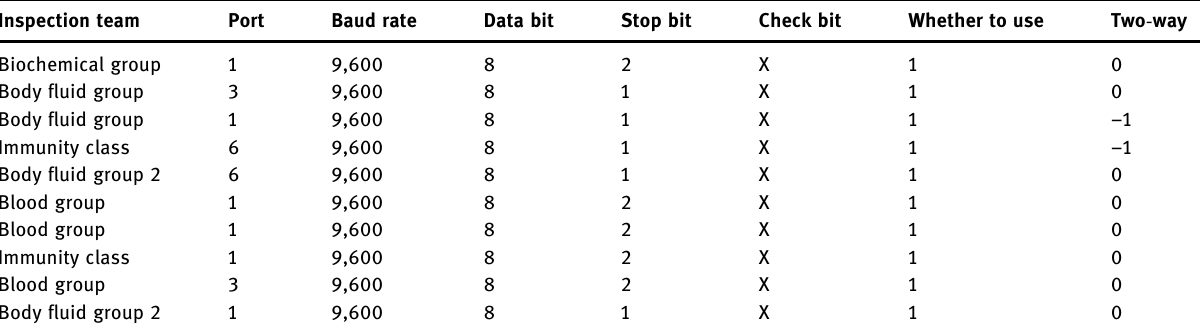
Table 1: Instrument communication settings for the LIS system Inspection team